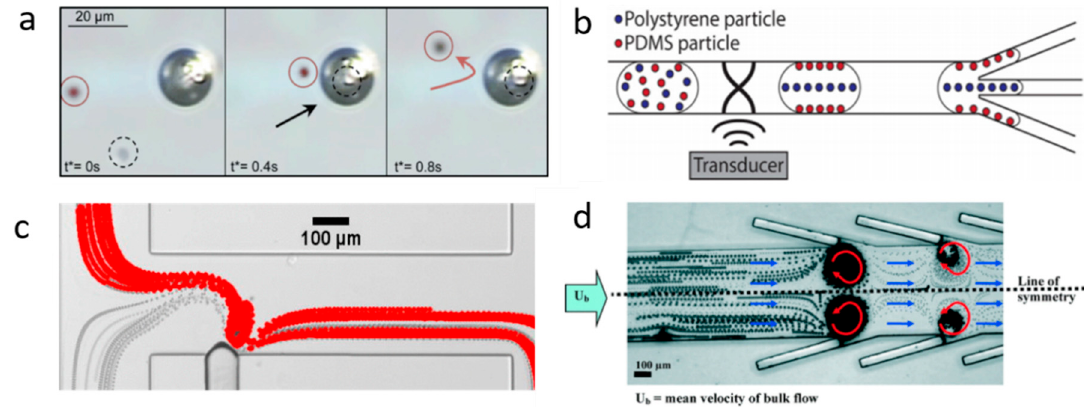
Figure 2. ( a ) At 217 kHz, 5 µ m silica particles are trapped by acoustic bubbles, while 5 µ m polystyrene particles follow with streamline due to the drag force. Reprinted with permission from reference [52].